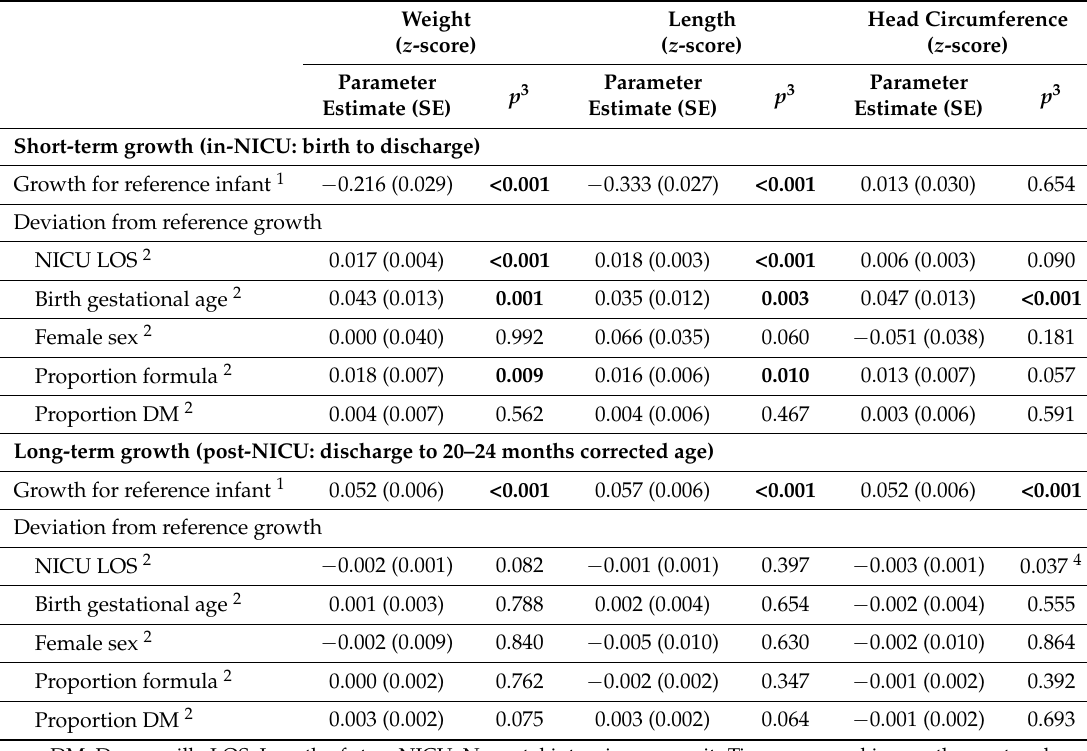
Table 3. Short- and long-term changes in growth